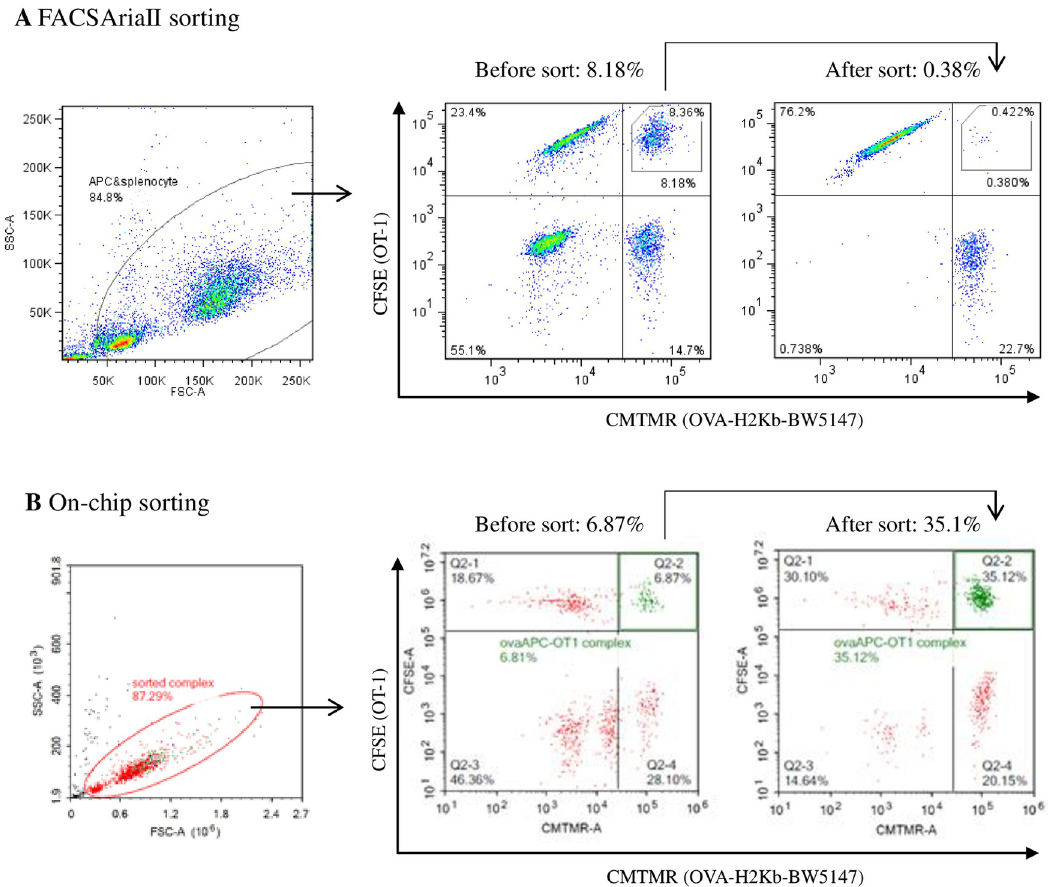
Fig 3. Specific cellular complex sorting using conventional sorter and microfluidics sorter. (A) OT-I/ovaAPC complexes (CFSE/ CMTMR double-positive fraction) were sorted using the FACSAria ™ II Cell Sorter. The sorted OT-I/ovaAPC complexes were also re-analyzed using FACSAria ™ II Cell Sorter. (B) The samples were similarly sorted using the microfluidics sorter, On-chip Sort, and re-analyzed using the conventional flow cytometer, NovoCyte 1